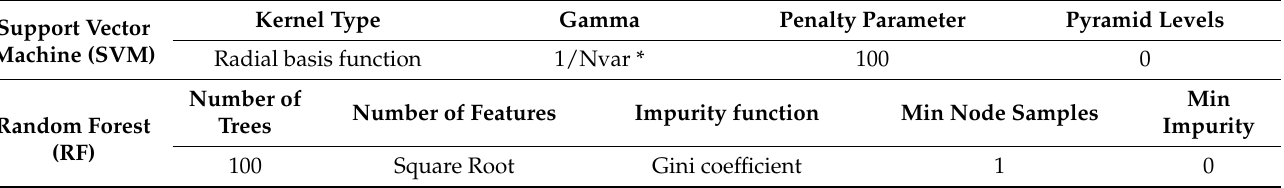
Table 5. Parameter settings of 2 classification algorithms.